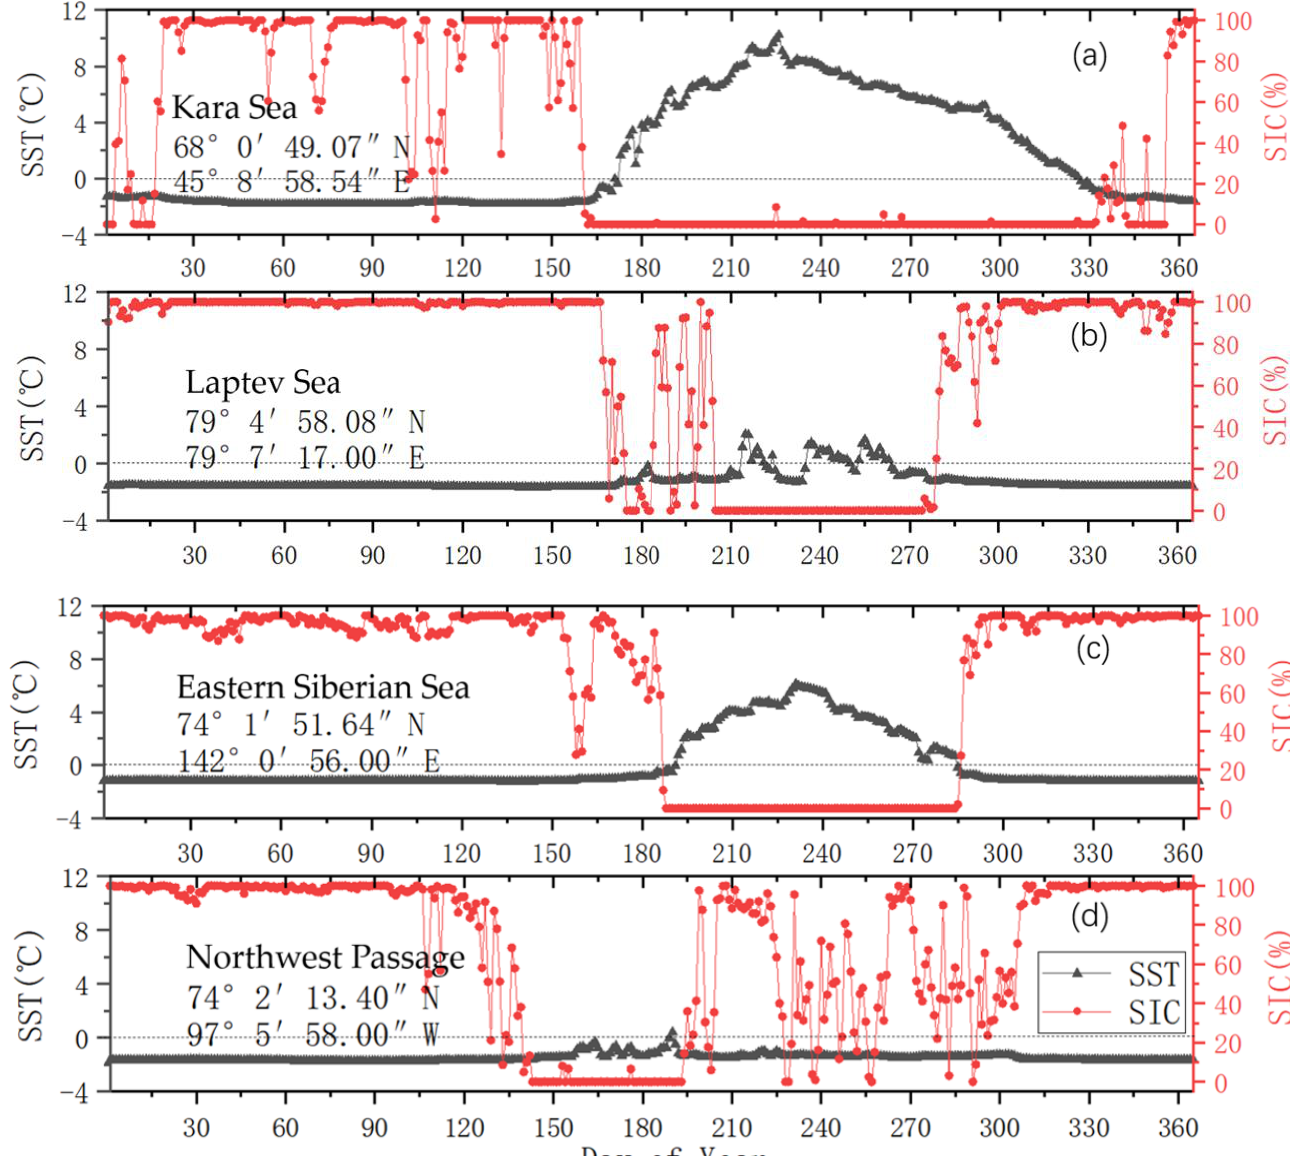
Figure 5. SST and SIC in the Arctic in 2021. The black line connected by the triangle is SST and the red line connected by the circle is sea ice concentration. ( a – d ) are points in the Kara Sea, Laptev Sea, East Siberian Sea, and Northwest Passage, respectively, and their corresponding coordinates are shown in the figure.